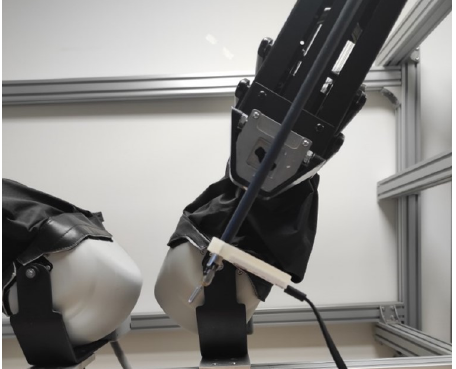
Figure 1. The developed sensing device mounted on the PSM of the dVRK system.